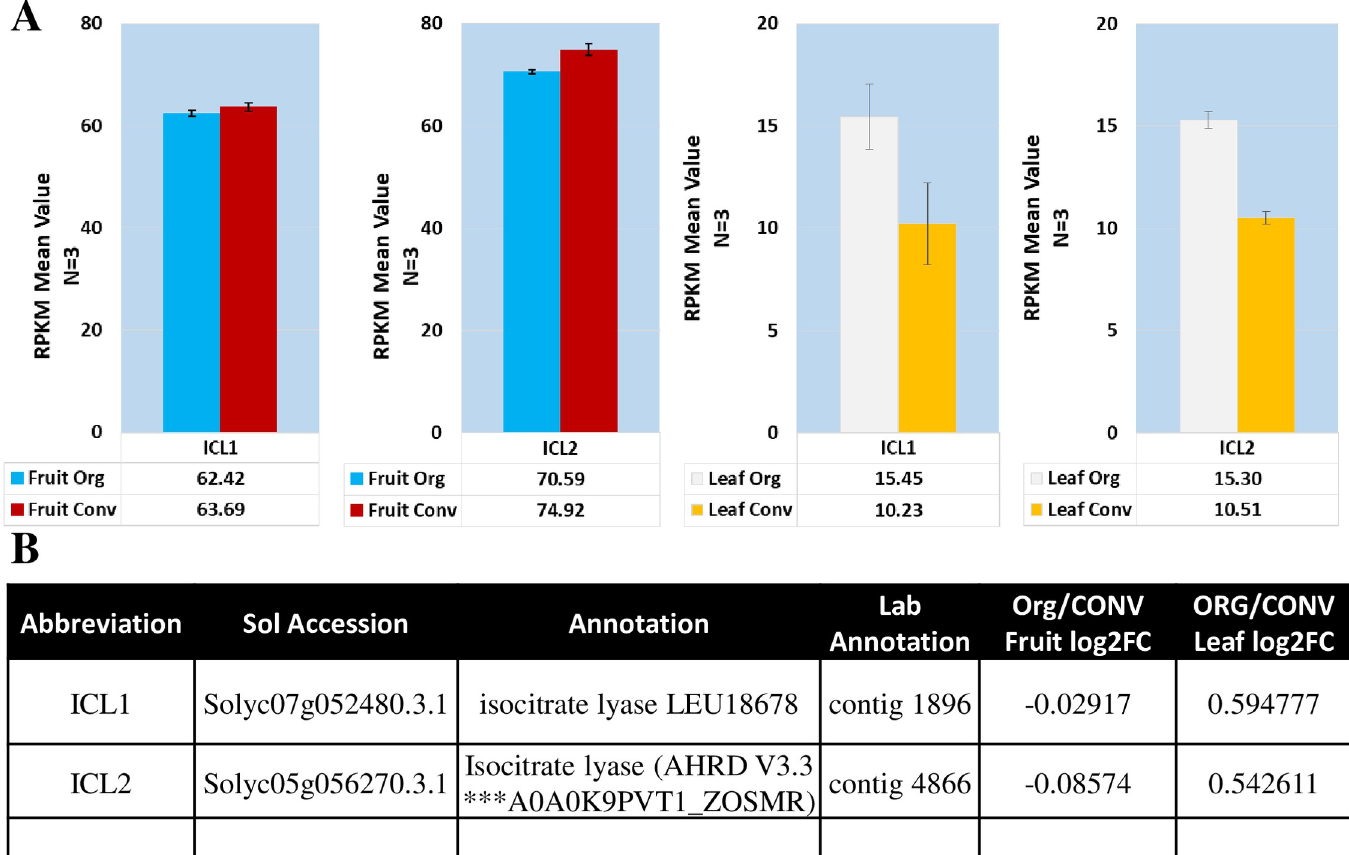
Fig 7. Differential expression of isocitrate lyase homologs. A. Mean expression values for the identified isocitrate lyase isoforms. B. Table of annotations and accession numbers from Sol Genomics ITAG3.2. Error bars denote the standard error of sequenced expression values between 3 biological